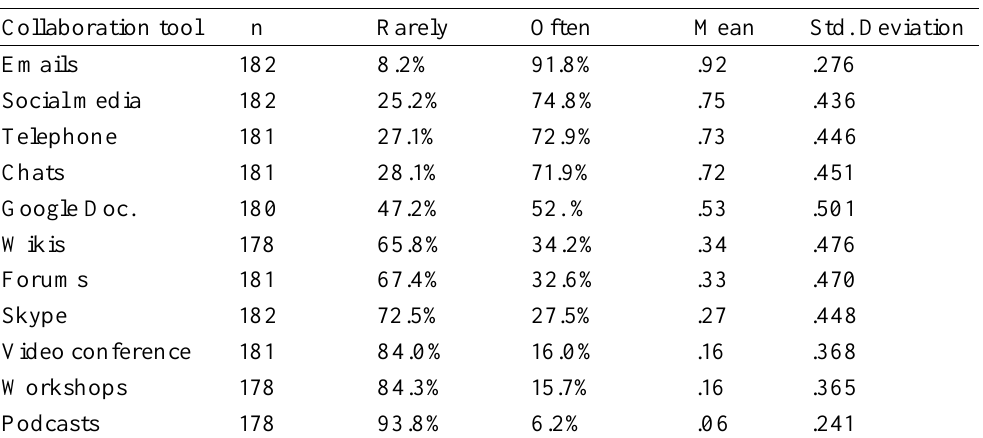
Frequency of Use on Various Collaborative Tools Collaboration tool n Rarely Often Std.